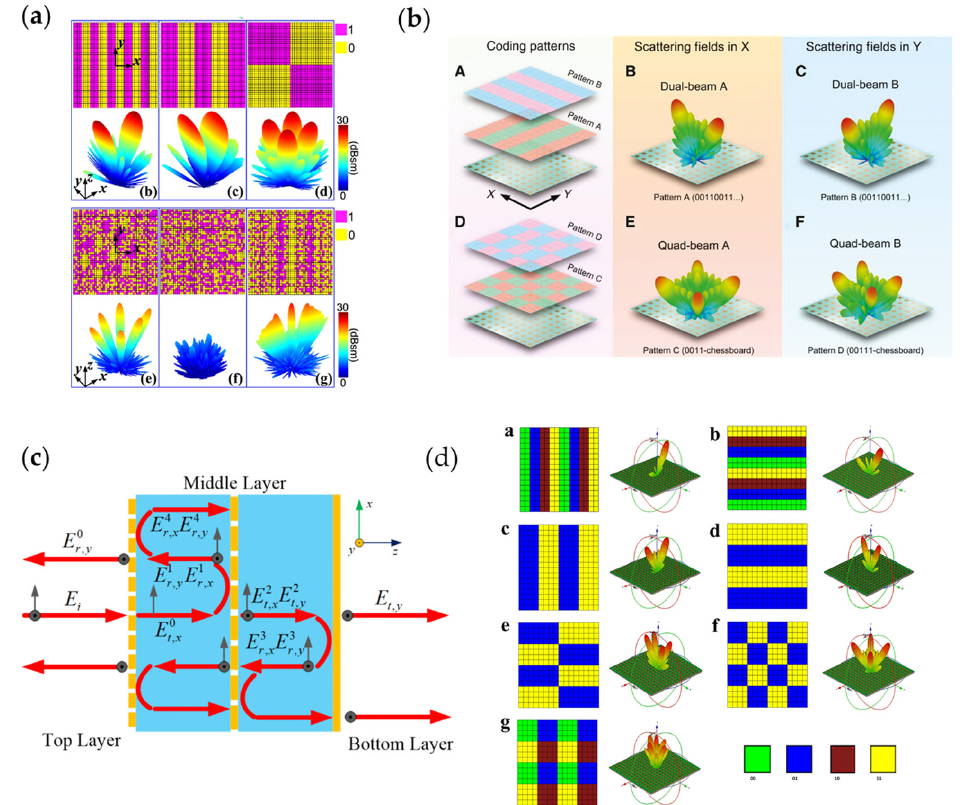
Figure 7. ( a ) 1-bit programmable digital coding metasurface and its far field patterns corresponding to the coding patterns; ( b ) Dual 1-bit programmable digital coding metasurface and its response to x and y-polarized waves; ( c ) Multi-layer 1-bit metasurface to achieve polarization conversion. © 2023 IEEE. Reprinted, with permission, from [204]; ( d ) 2-bit programmable digital coding metasurface and its far field patterns, the far field patterns are more abundant than the 1-bit metasurface.